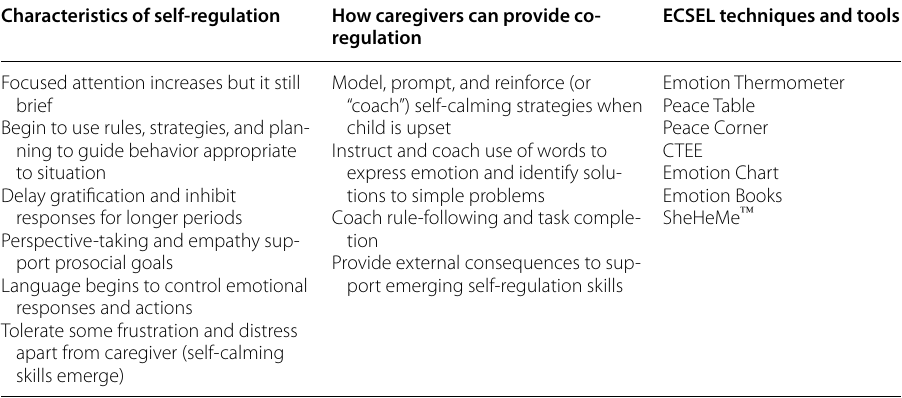
Table 2 Promoting the growth of self‑regulation development and co‑regulation for ages 3–5: ECSEL approach. Adapted from Murray et al. (2016b) Characteristics of